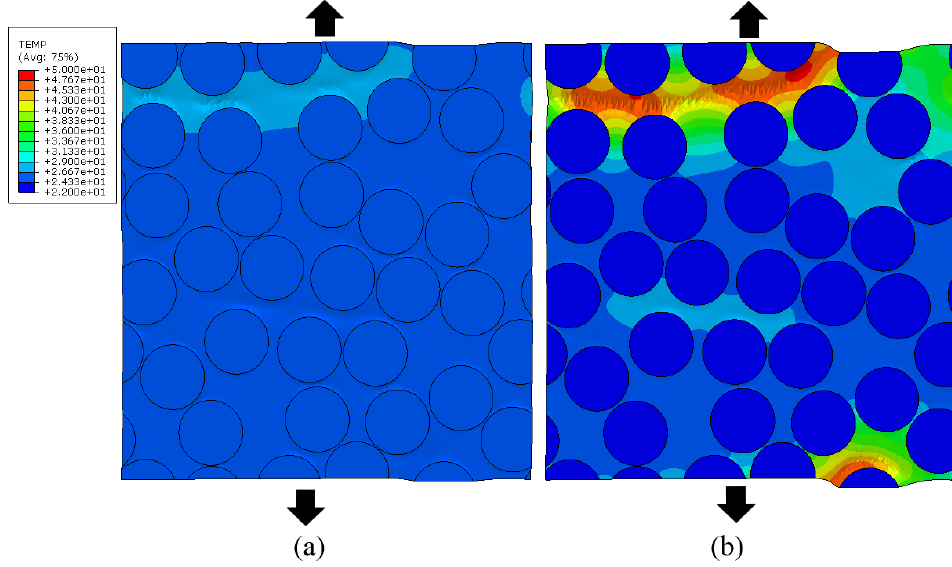
Figure 9. Temperature distribution for the RVEs with Vf. 60% at a strain of 0.037 [-]. strain rate 1. [s −1 ] ( a ) and 100. [s −1 ] ( b ).